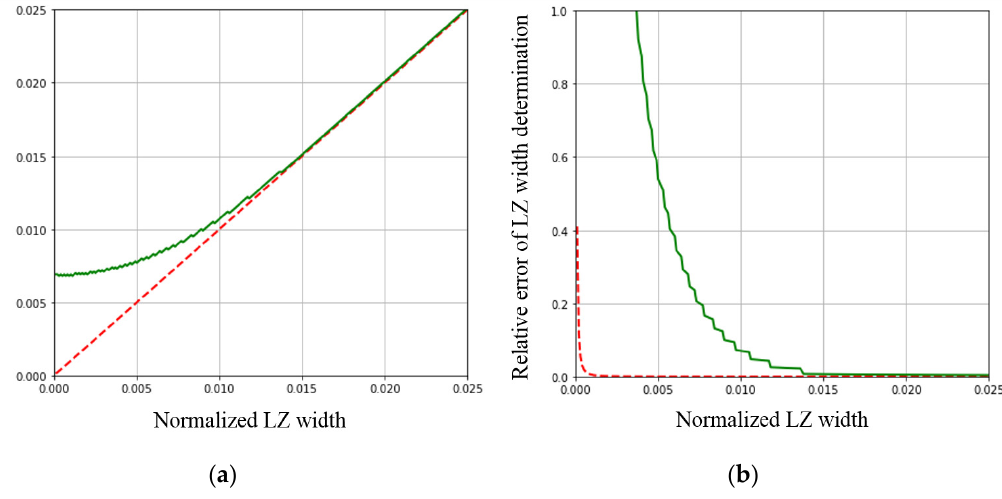
Figure 8. Results of the reconstruction of the light zone width by the video signal 𝑣(𝑡̂) (solid line— for the conventional method for the reconstruction using the first derivative of the video signal 𝑣(𝑡̂) ; dashed line—for the reconstruction with the use of the SSPs): ( a ) the dependence of the measured values of the normalized width of the LZ on the real values of the width; ( b ) relative error of the LZ width determination depending on its real value.